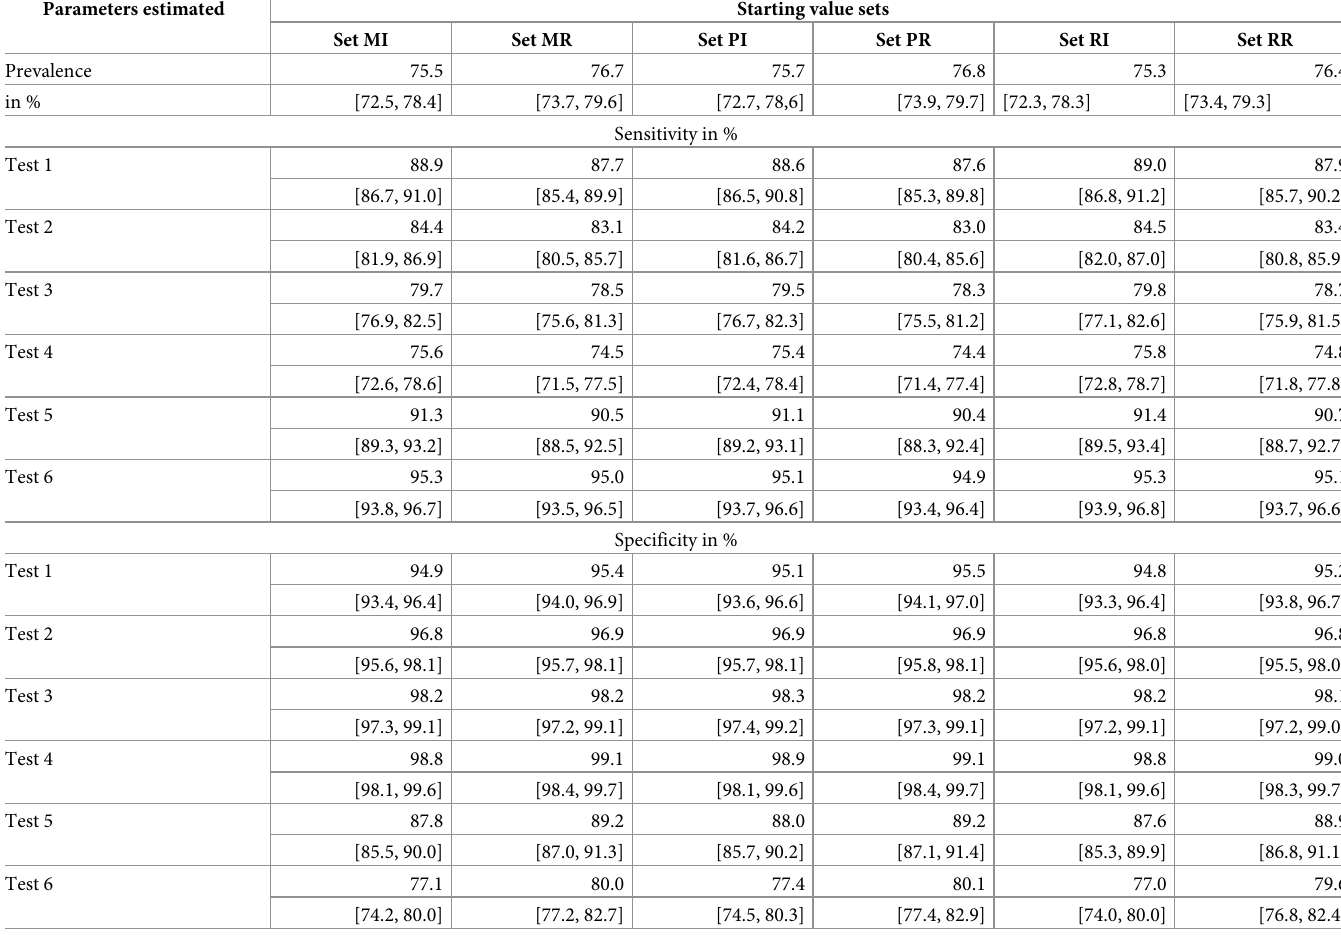
Table 2. Estimated values for the prevalence and the test accuracies for the six starting value sets for the complete sample with confidence limits reported in brack- ets (rounded to one digit). Parameters